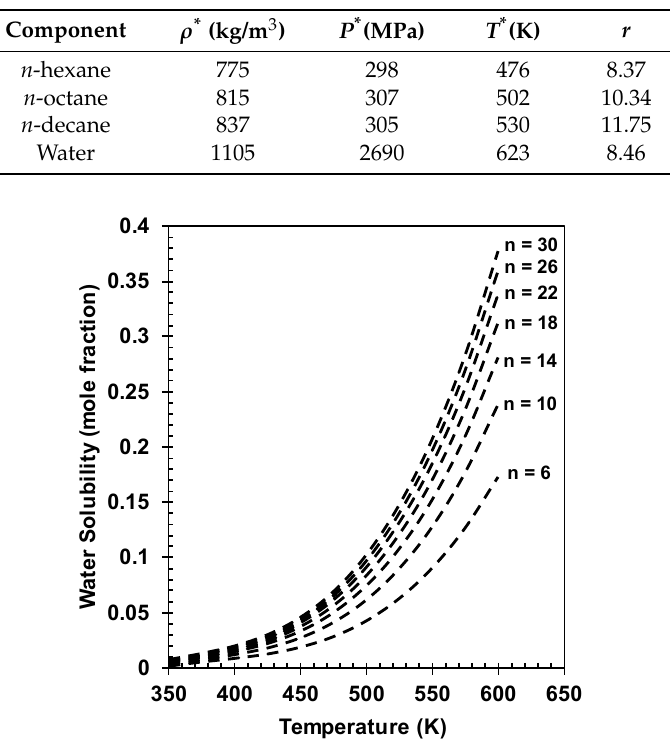
Figure 1. Solubility of water in C 6 to C 30 hydrocarbons at 5 MPa.